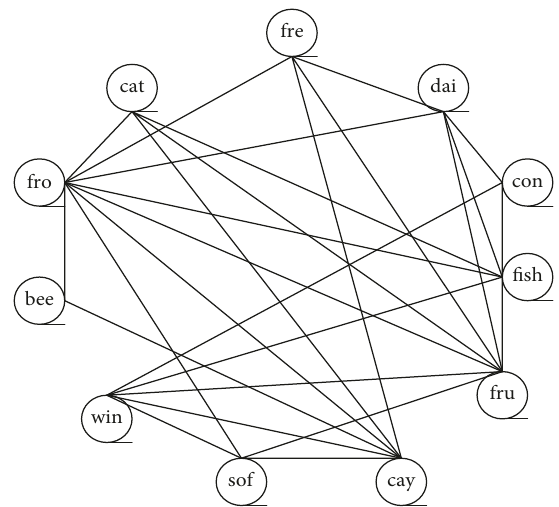
Figure 3: The relation schema of association rules.